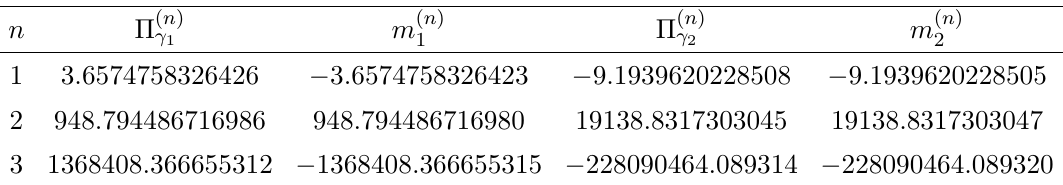
Table 1 . The WKB expansion of the quantum periods for the cubic oscillator with E = 1 = 200 and (cid:20) = 1. The numerical calculation in the TBA system is done by Fourier discretization with 2 12 points and a cuto(cid:11) ( L; L ) where L = (cid:0)